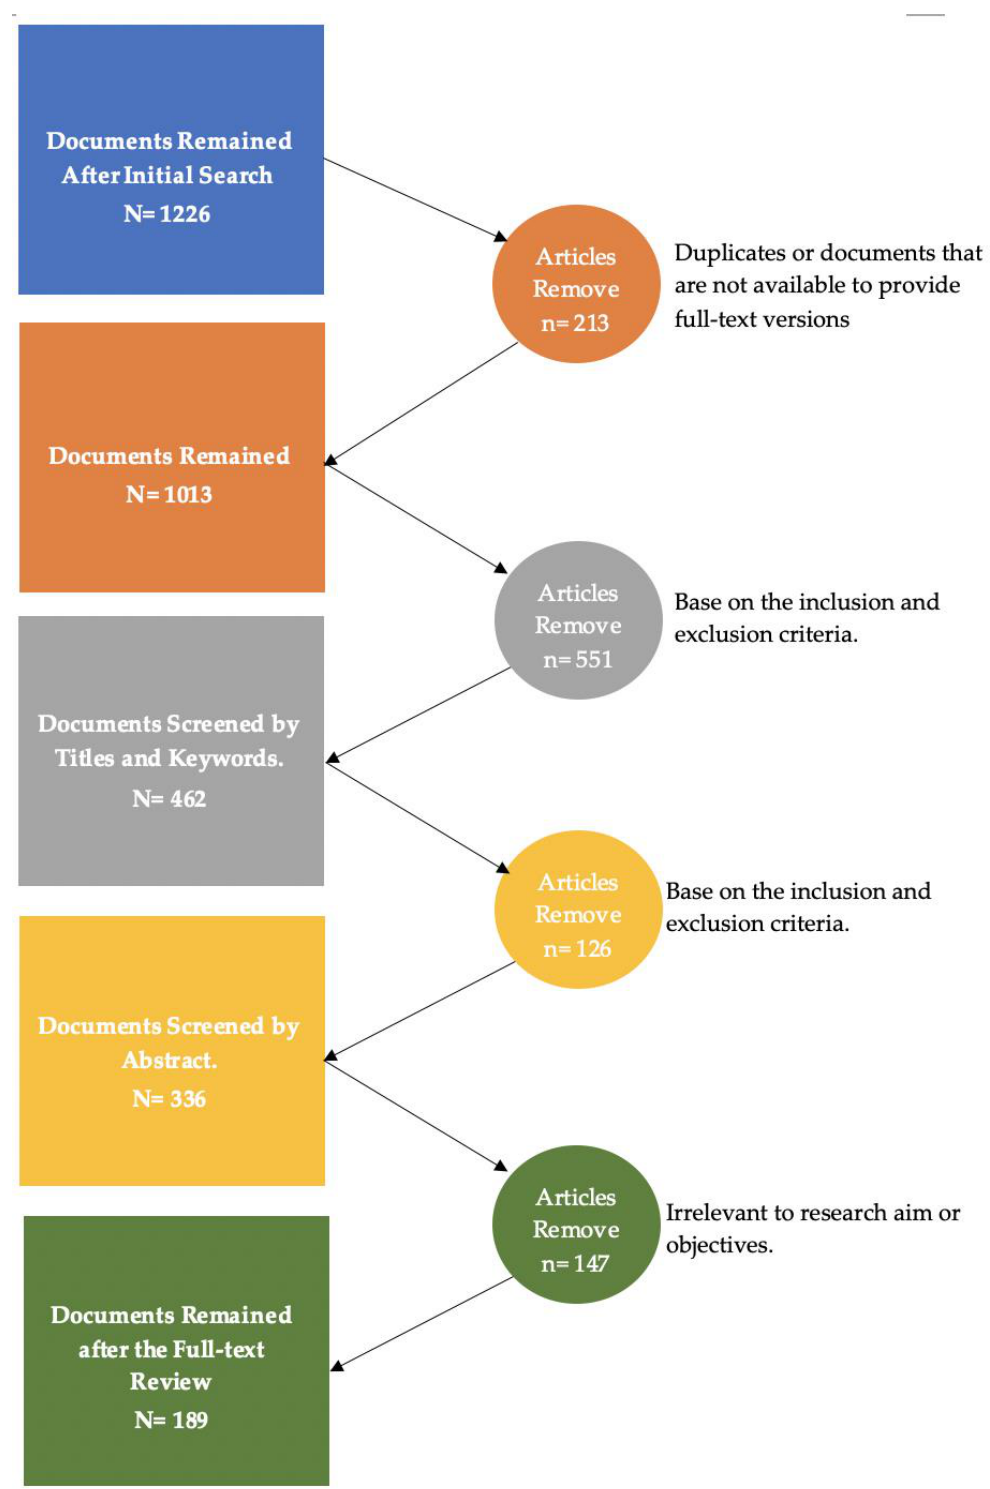
Figure 2. The flow chart of article searching and screening.